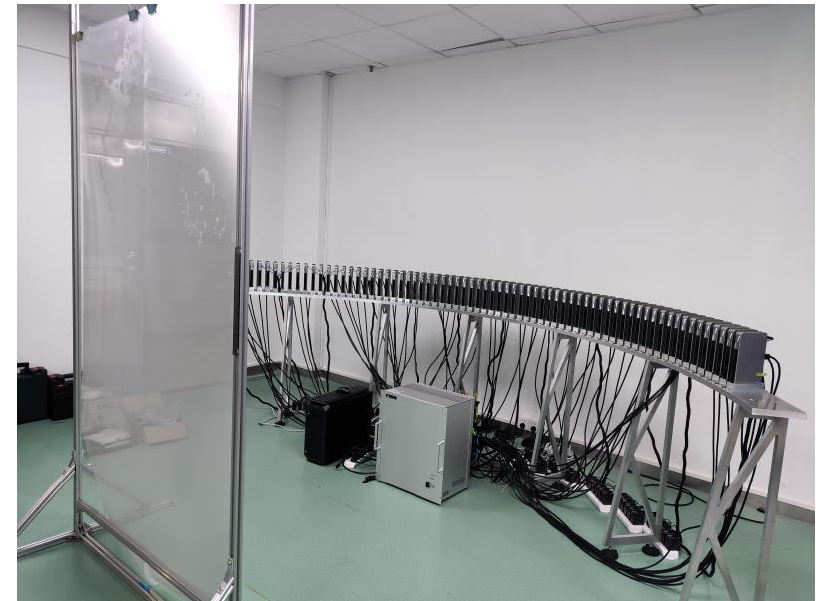
Figure 6. Picture of the real display system structure .